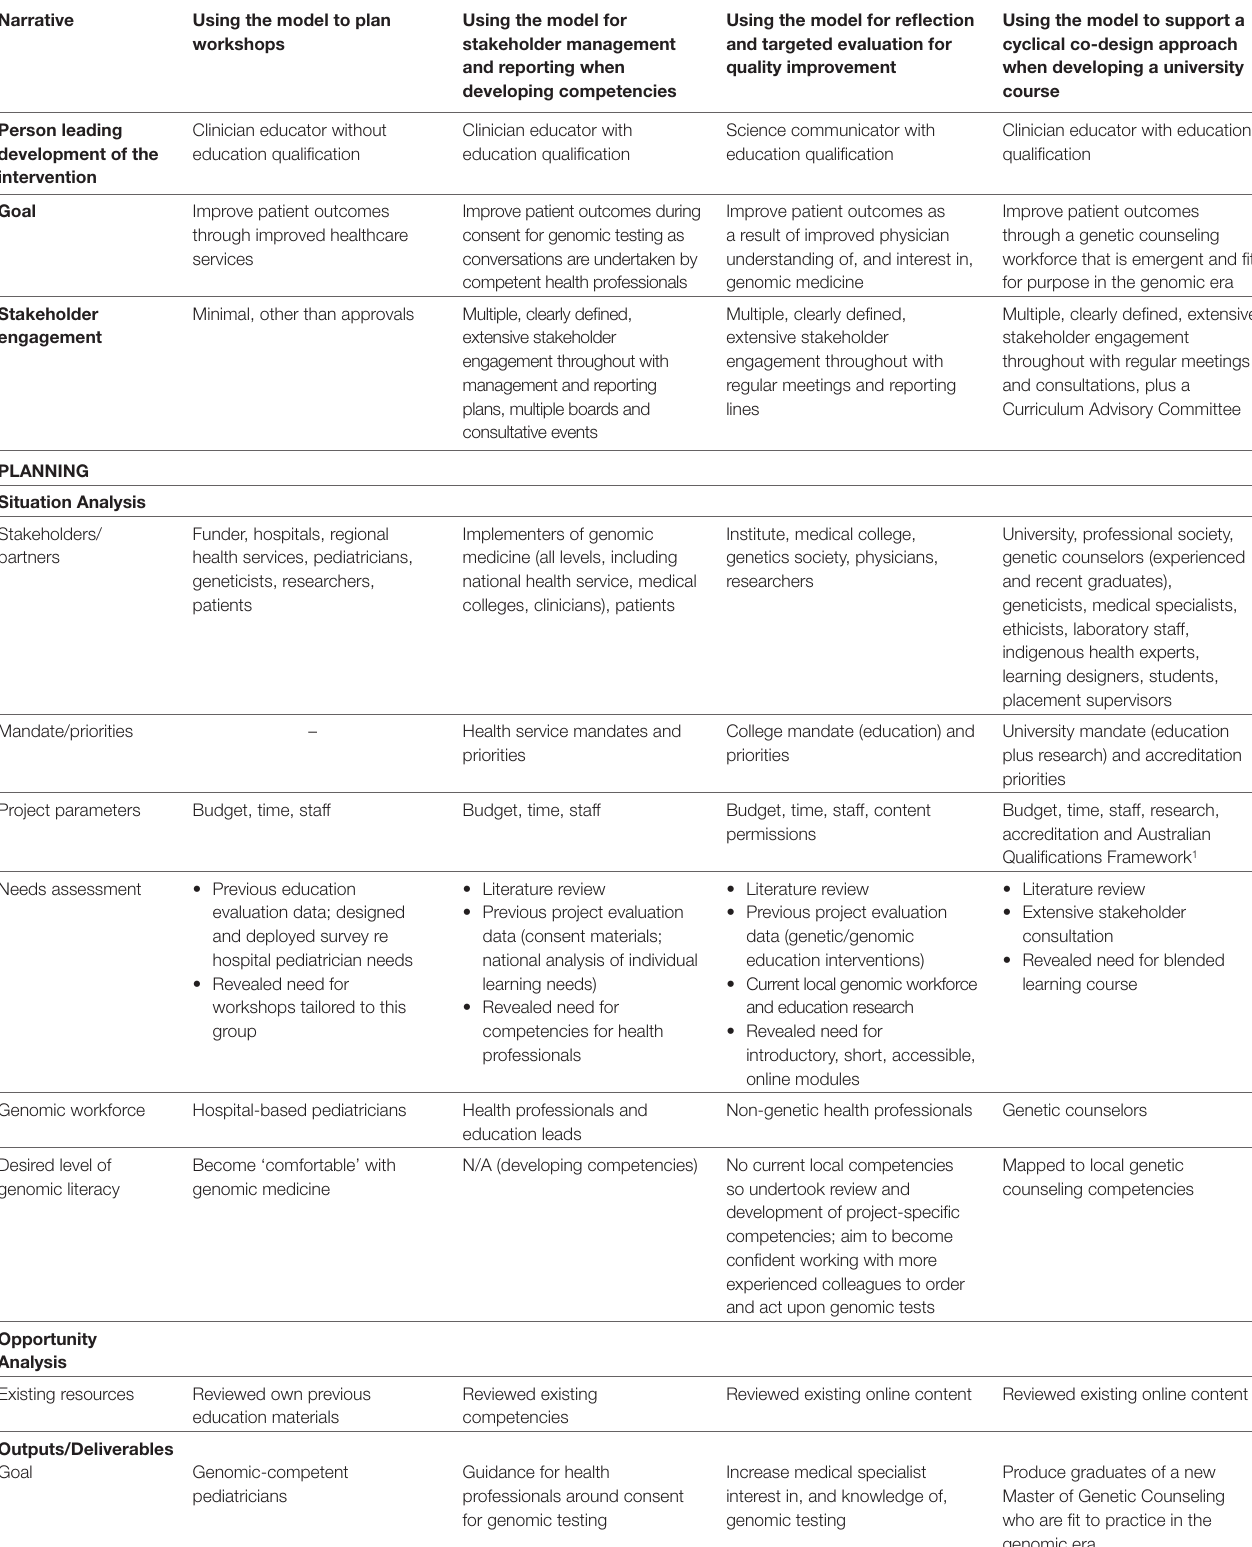
TABLE 1 | Comparing components within the program logic model across four illustrative